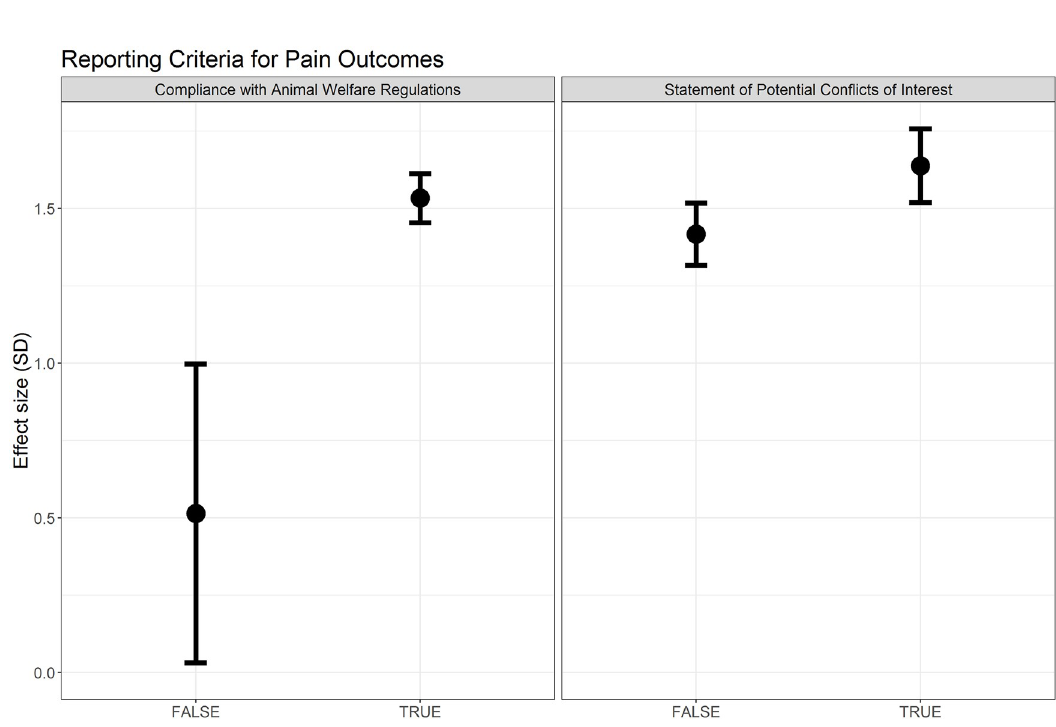
Fig 14. Effect sizes associated with reporting of compliance with animal welfare regulations and a statement of potential conflict of interests in intervention experiments using pain-related behavioural outcomes (data set 2a).